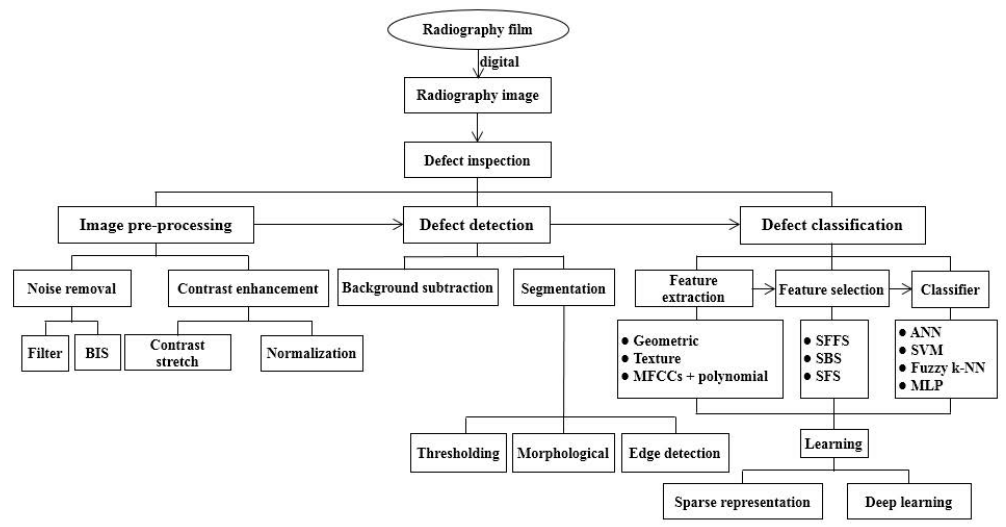
Figure 2. Flowchart of the review for studies on automatic welding defect